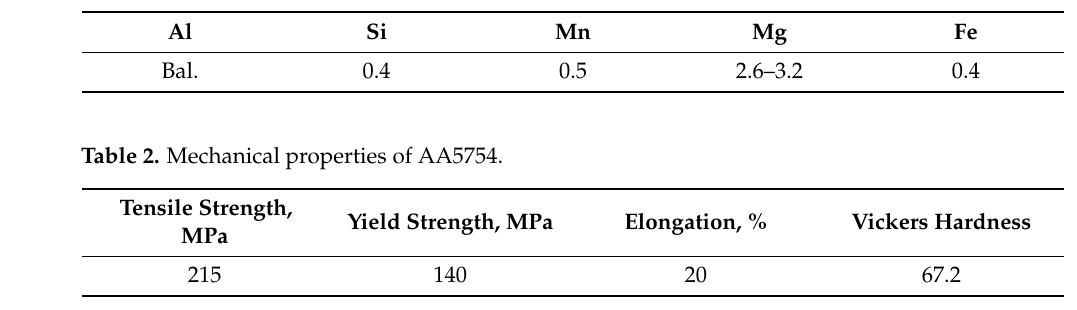
Table 1. Chemical composition of AA5754.